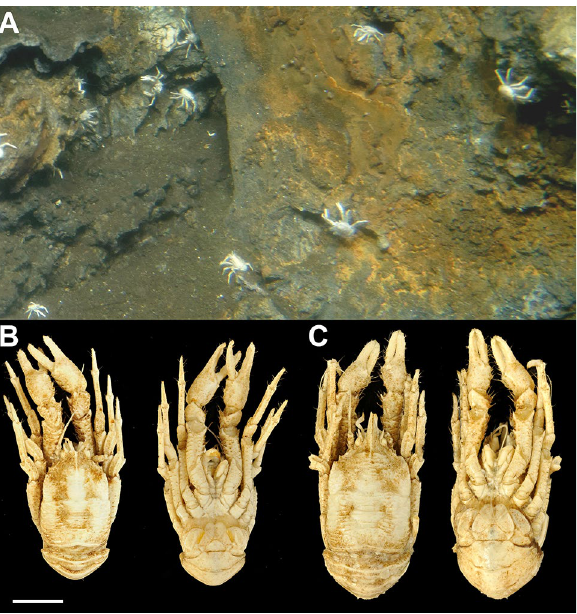
Figure 1. Munidopsis alvisca specimens ( A ) at the hydrothermal vent site Rebecca’s Roost (Guaymas Basin, Mexico) at 1996 m depth ( Alvin dive 4995). Animals were collected with the submersible’s slurp gun. Dorsal and ventral views of ( B ) a male and ( C ) a female M. alvisca specimen (scale 1 cm) collected at Rebecca’s Roost. Pictures taken by Thorsten Brinkhoff and Nicol